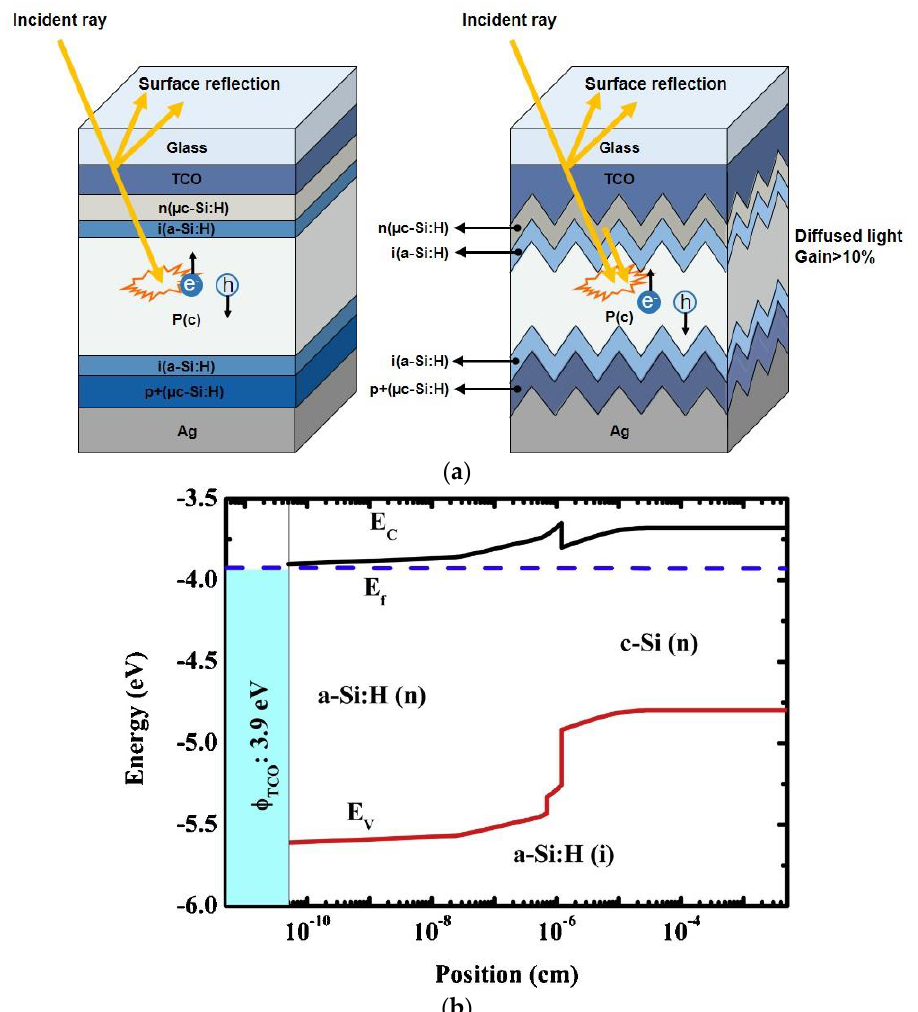
Figure 2. ( a ) The SHJ solar cell with flat and textured TCO layer (this figure was reprinted